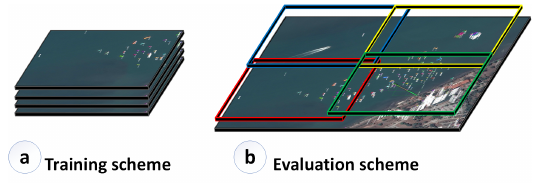
Figure 3. Tiling Schemes. We train our model on independent image patches, but for the evualuation process we produce detection lists on overlapping patches.